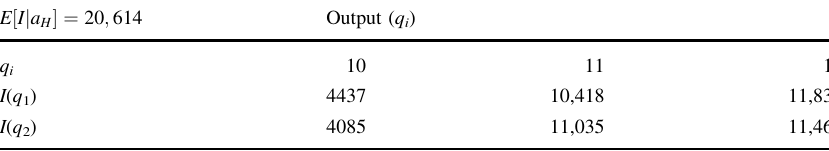
Table 3 Pay for performance with transfer and adjusted